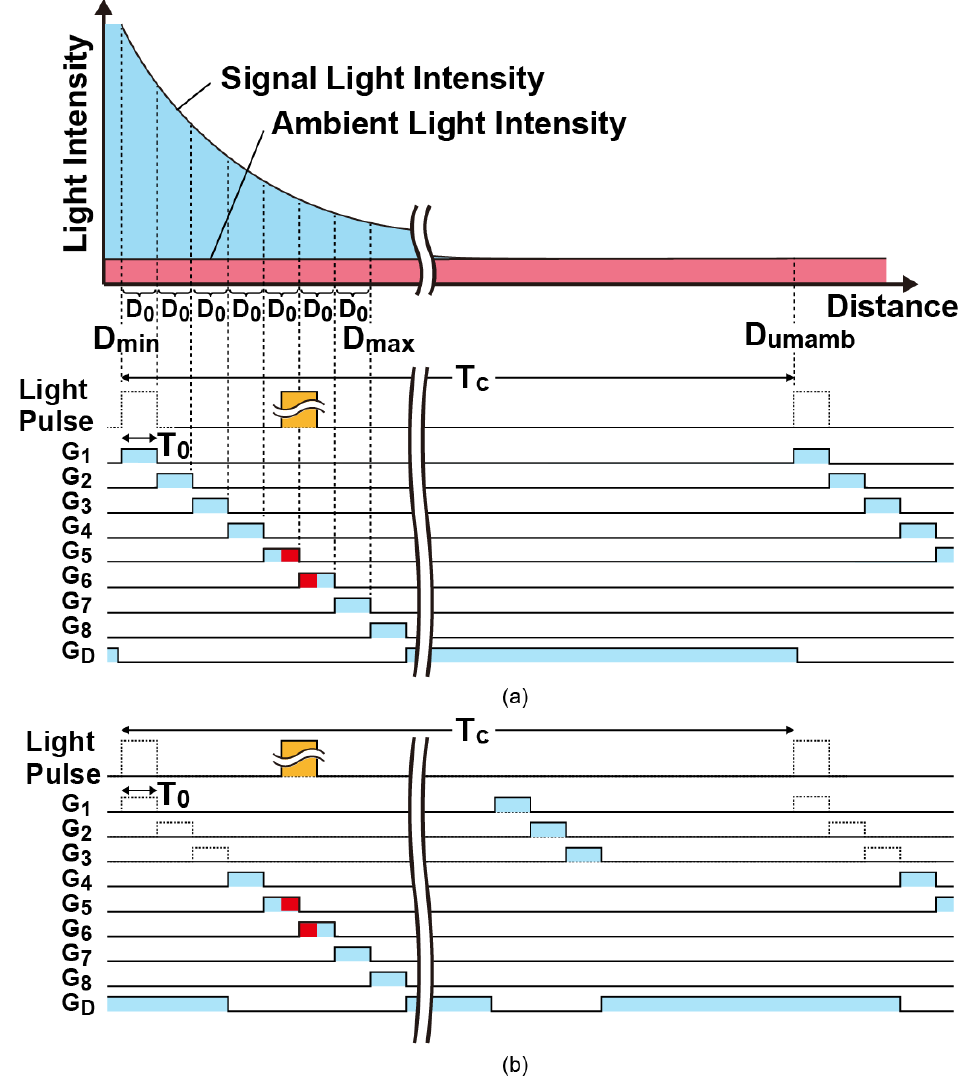
Figure 4. Gate timing and its correspondence to the depth range to be measured: ( a ) Gate timing when all the gates are activated in every cycle and its correspondence to the distance profile of the back-reflected light intensity; ( b ) Gate timing when G 4 –G 8 are activated for signal light sampling and G 1 –G 3 are activated for ambient light sampling.